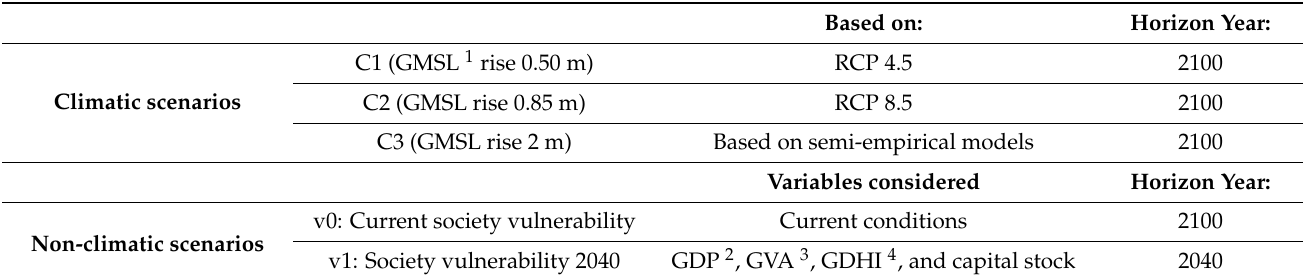
Based on: Horizon Year: Based on semi-empirical models 2100 Variables considered Horizon Year: